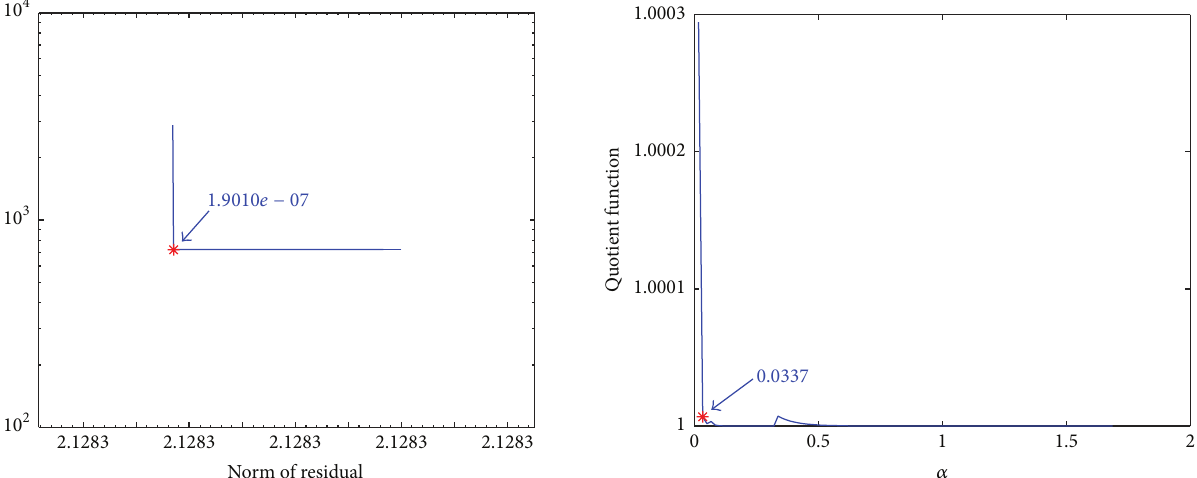
Figure 26: QF in experiment of MIMO